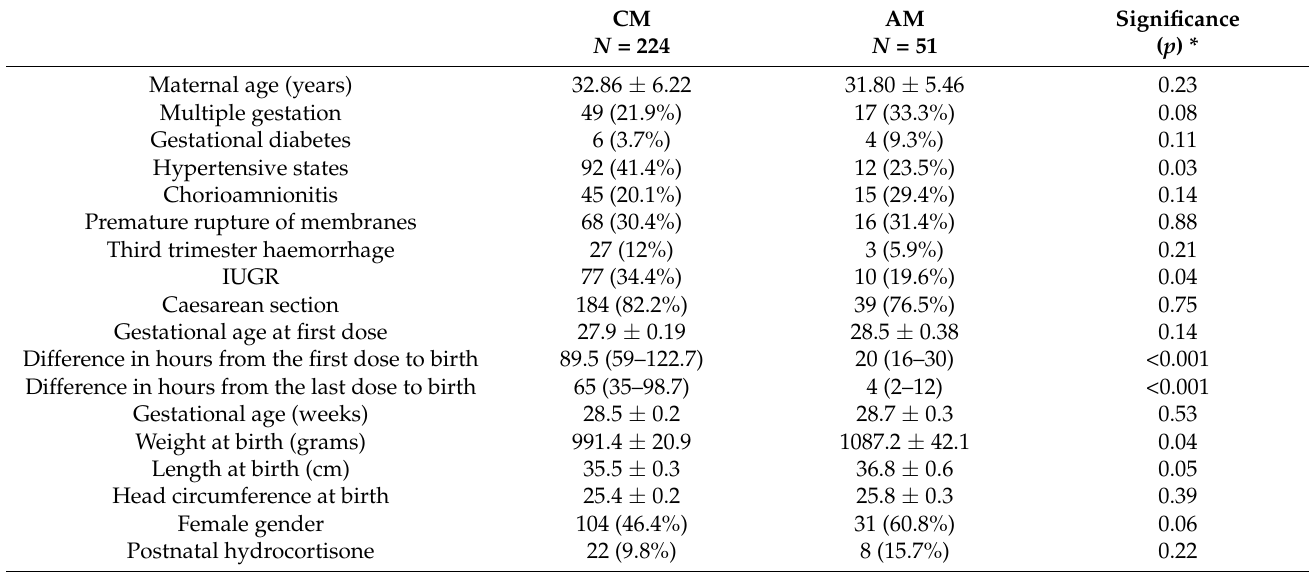
Table 1. Cohort characteristics with regard to the interval between antenatal corticosteroid